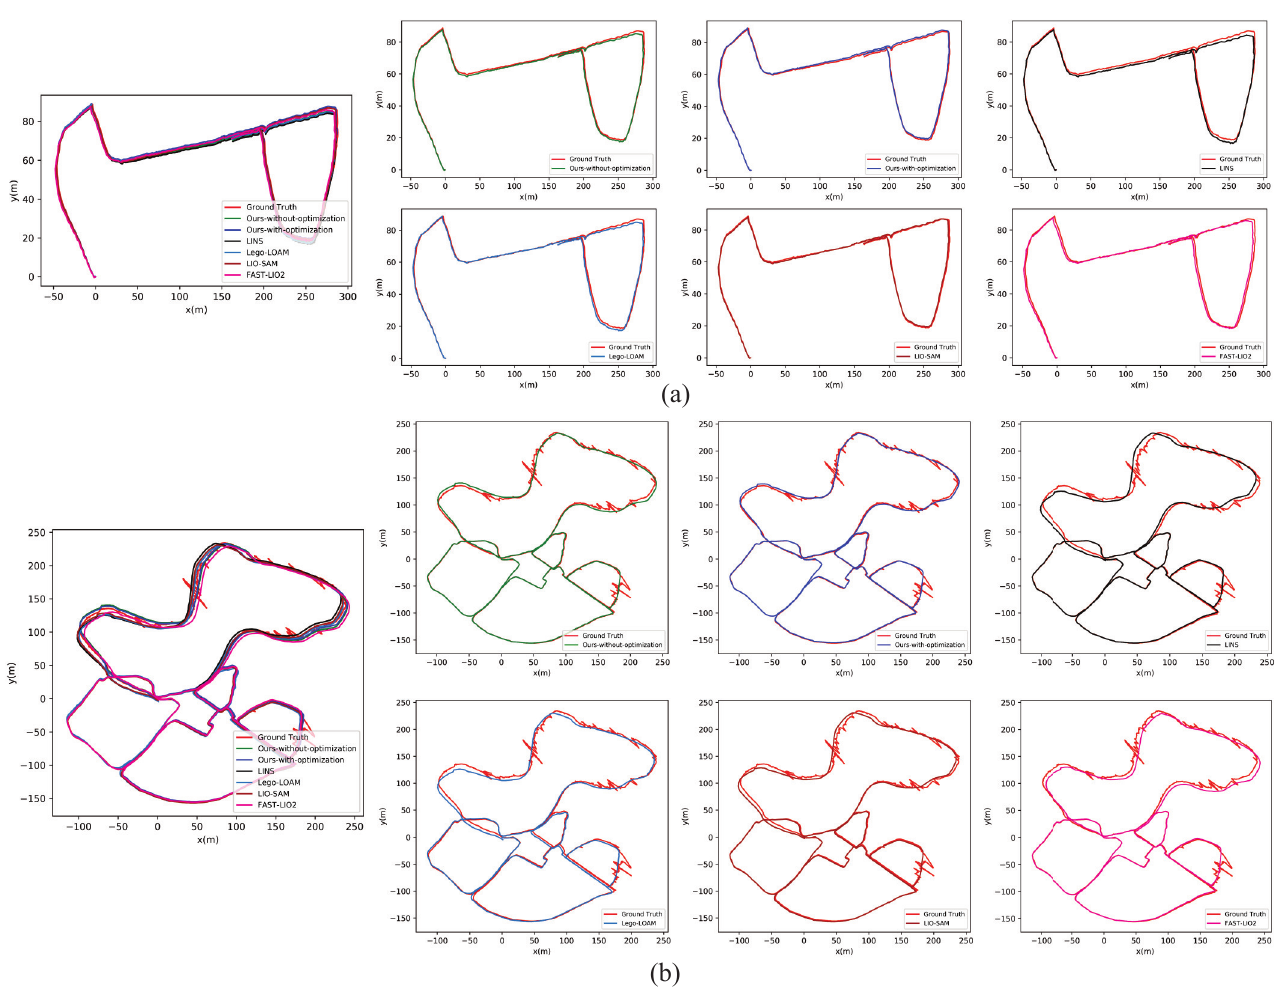
Figure 5. Trajectories of the datasets estimated by different LIO systems. ( a ) The trajectories evalu- ated in small-scale dataset. ( b ) The trajectories evaluated in large-scale dataset. In the small-scale dataset, GPS ground truth is available everywhere, whereas, in the large-scale dataset, GPS signal is partial available because of the blocking of forests. The ground truth will drift considerably in GPS-denied